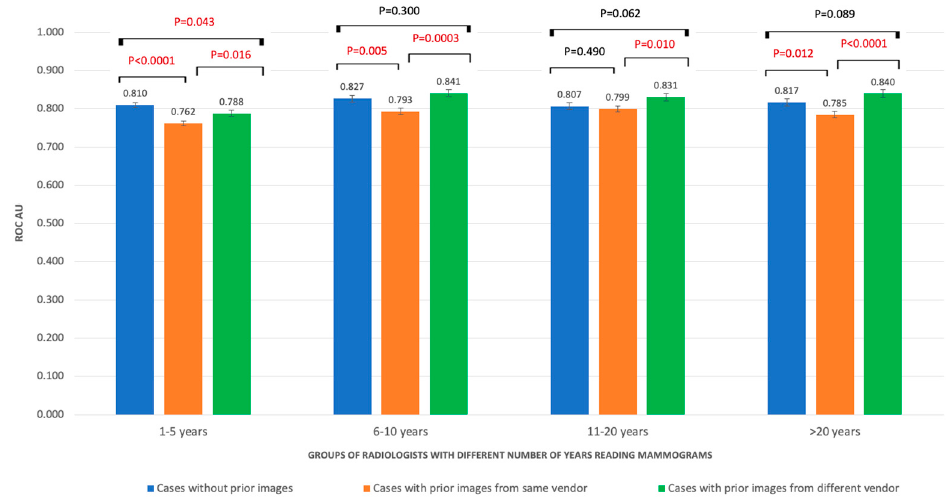
Figure 3. ROC AUC performances of radiologists with different experience in number of years reading mammograms.